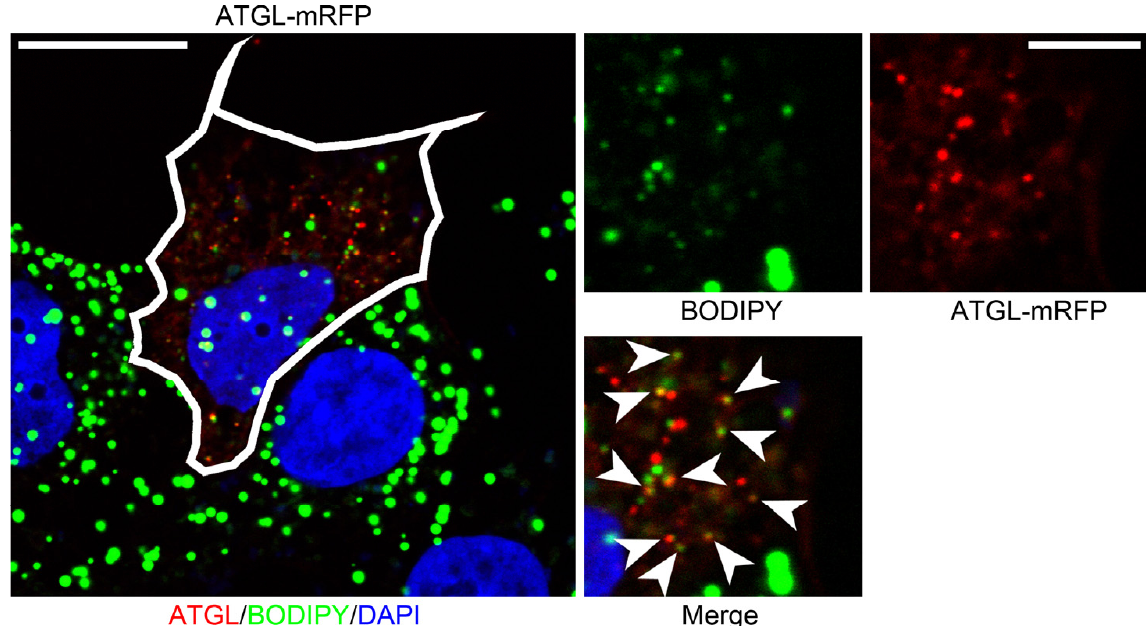
Figure A7. ATGL-positive foci colocalize with LDs. Immunofluorescence analysis of ATGL-positive foci (red) in transfected HepG2 cells. HepG2 cells were transfected with mRFP-tagged ATGL (red; nuclei: DAPI, blue). The majority of ATGL-positive foci colocalize with small residual LDs (BODIPY: green). Arrowheads indicate residual ATGL/BODIPY double-positive foci. Scale bars: 15 µm and 5 µm for magnified images.